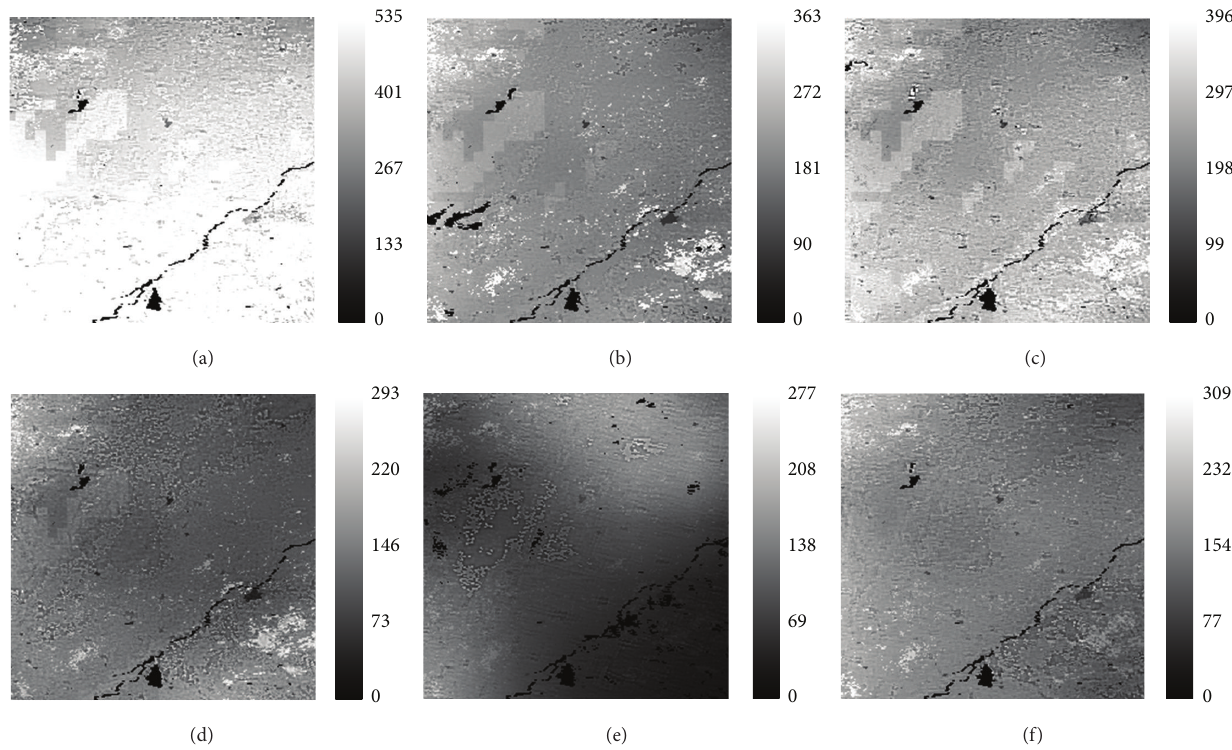
Figure 5: The assimilated EPs from the EnKF method at 15:00 solar time. (a) The assimilated EP on May 2, 2005; (b) the assimilated EP on May 7, 2005; (c) the assimilated EP on May 14, 2005; (d) the assimilated EP on May 19, 2005; (e) the assimilated EP on May 25, 2005; (f) the assimilated EP on May 31, 2005.